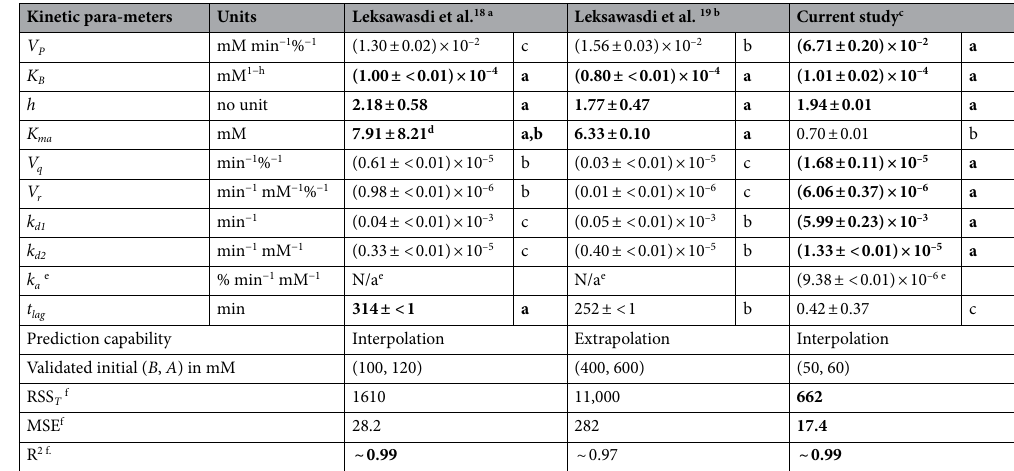
Table 4. Comparison of normalized kinetic parameters from literatures and current study. Values with different capital alphabets (a—c) in the same row indicated statistically significant difference ( p ≤ 0.05). Statistical parameters with the highest statistically significant ( p ≤ 0.05) or best values were bolded. a 2.5 M MOPS with ( B / A ) of (50/60), (100/120), (150/180) mM using initial volumetric PDC activity of 1.1–3.4 U mL −1 . b 2.5 M MOPS with ( B / A ) of (400/600) mM using initial volumetric PDC activity of 8.4 U mL −1